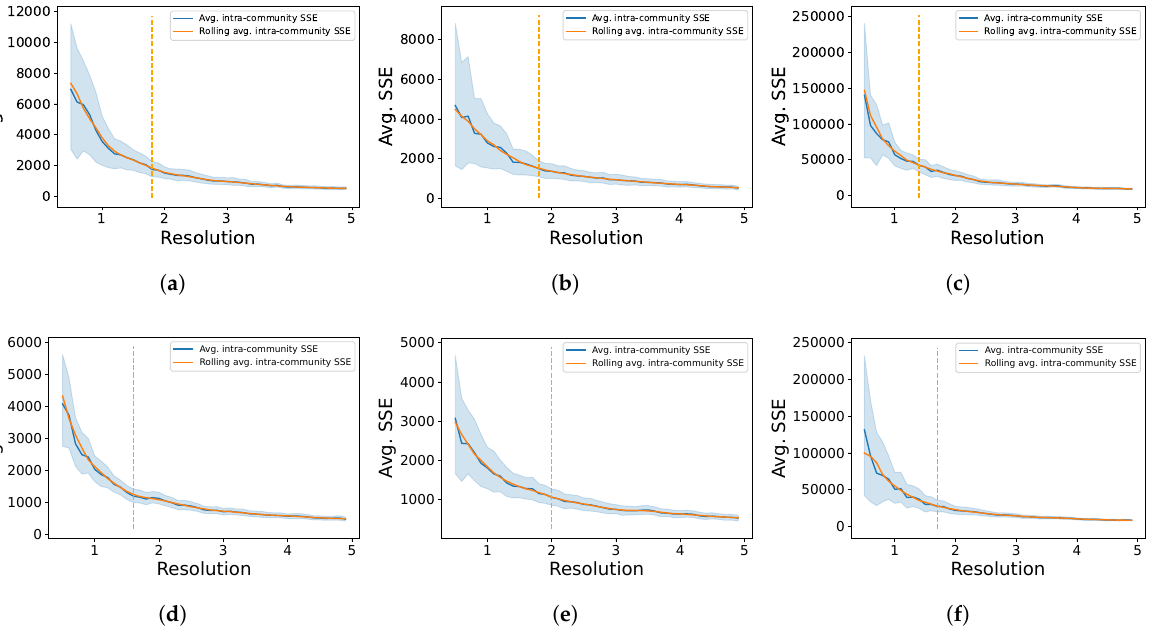
Figure 1. Average SSE as a function of the resolution parameter r . The elbow point (denoted as a vertical dashed line) was determined on the moving average plot (window = 5) in order